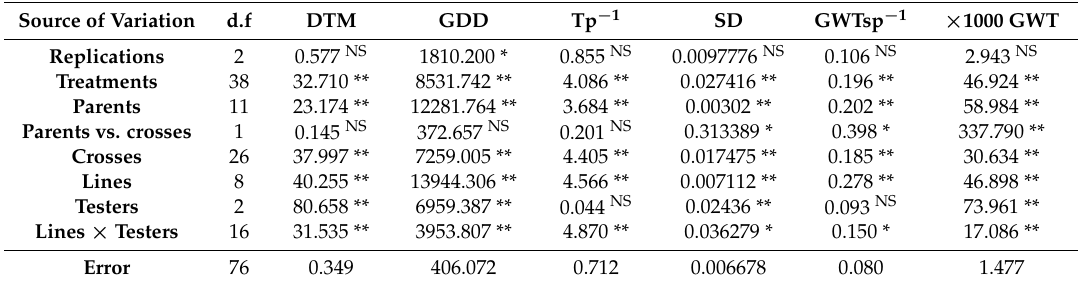
Table 1. Mean square (MS) values from analysis of variance (ANOVA) for metric traits.